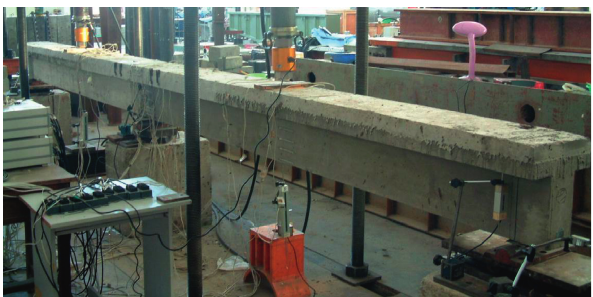
Figure 11: Two-span continuous composite T-shaped beam actual test setup.